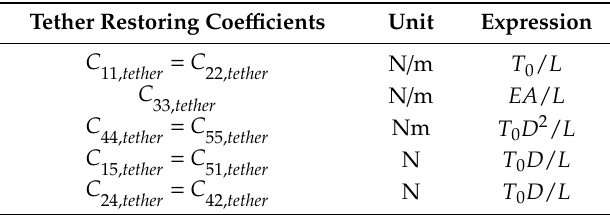
Table 3. Restoring coe ffi cient of the single